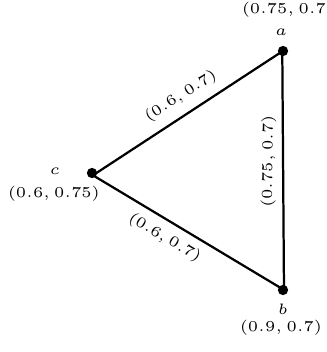
Figure 6. A 3-rung orthopair fuzzy induced subgraph H Figure 3.4: A 3-rung orthopair fuzzy induced subgraph H